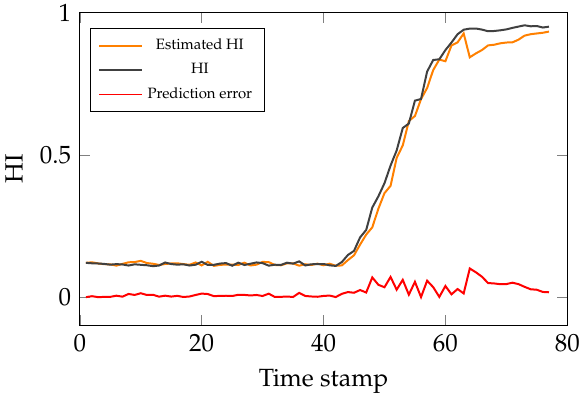
Figure 18. Simulation results for HI estimation using the degradation model.